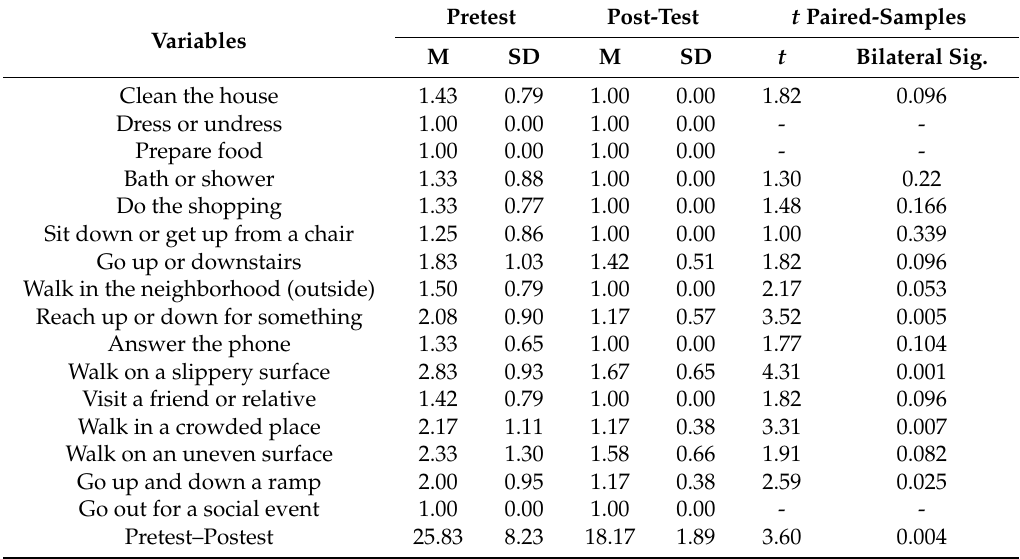
Table 2. FEES-I pre-post intervention scores and values by variables analyzed and complete group. Pretest Post-Test t Paired-Samples Variables